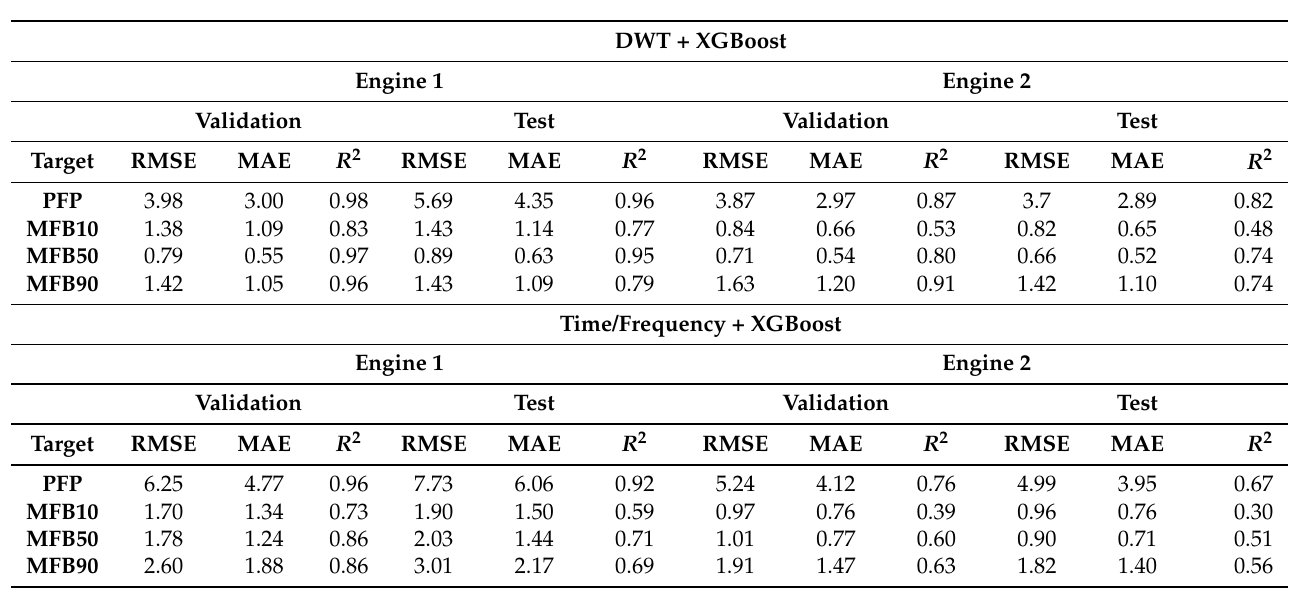
Table 3. Summary of regression results for all selected combustion parameters of introduced approach and comparison